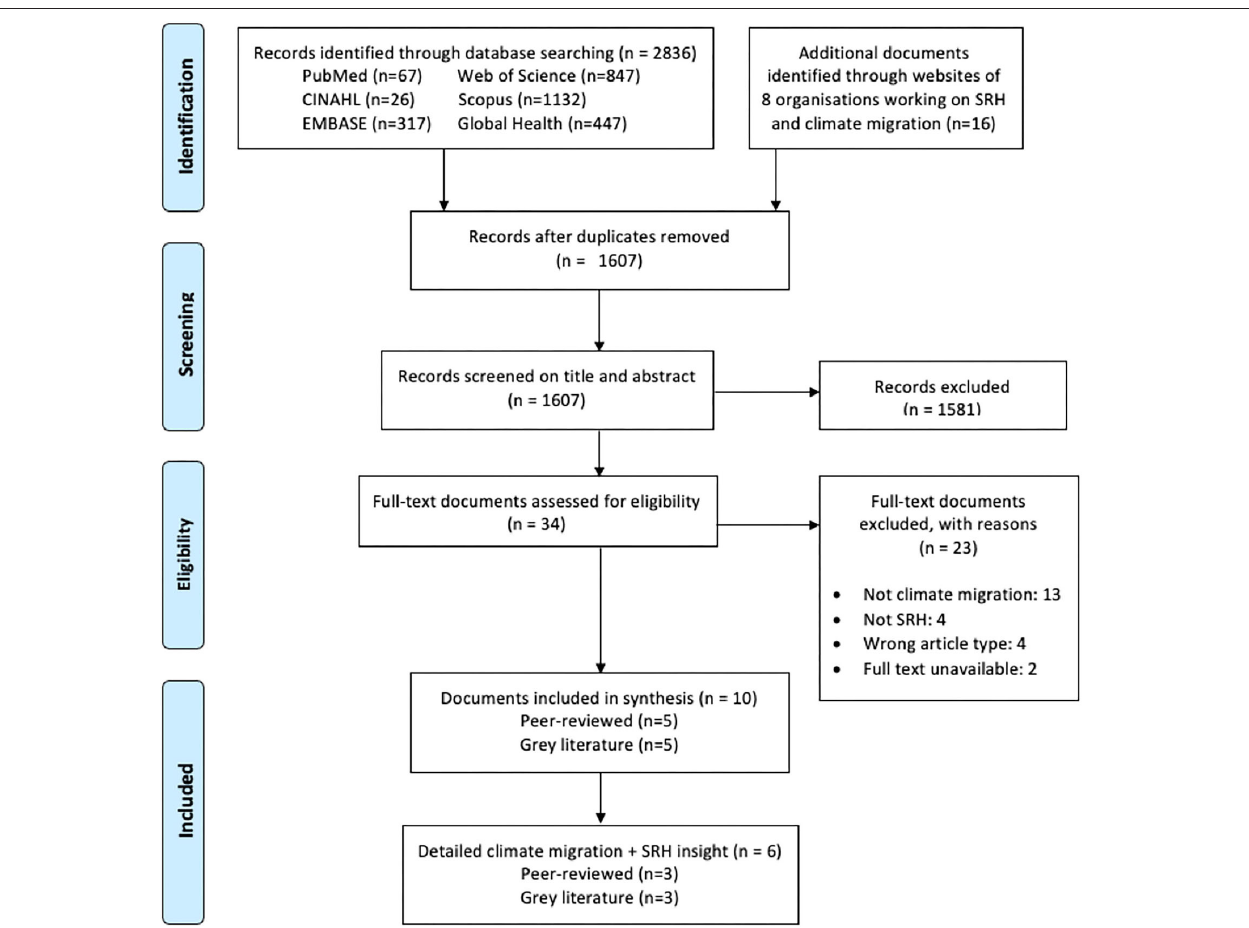
FIGURE 1 | Flow diagram of study selection